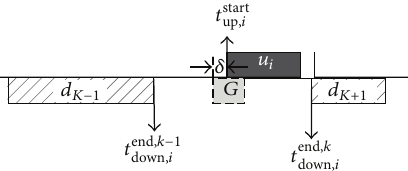
Figure 5: Start time of the ONU 𝑖 upstream transmission between two downstream transmissions.